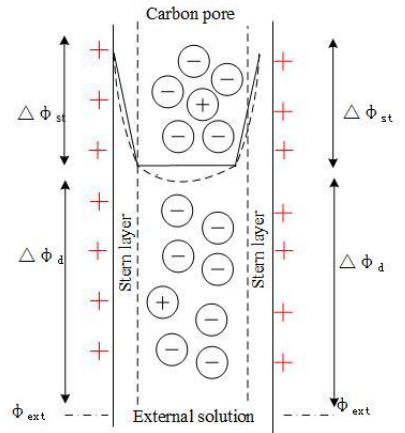
Figure 3. Diagram of the modified Donnan model.